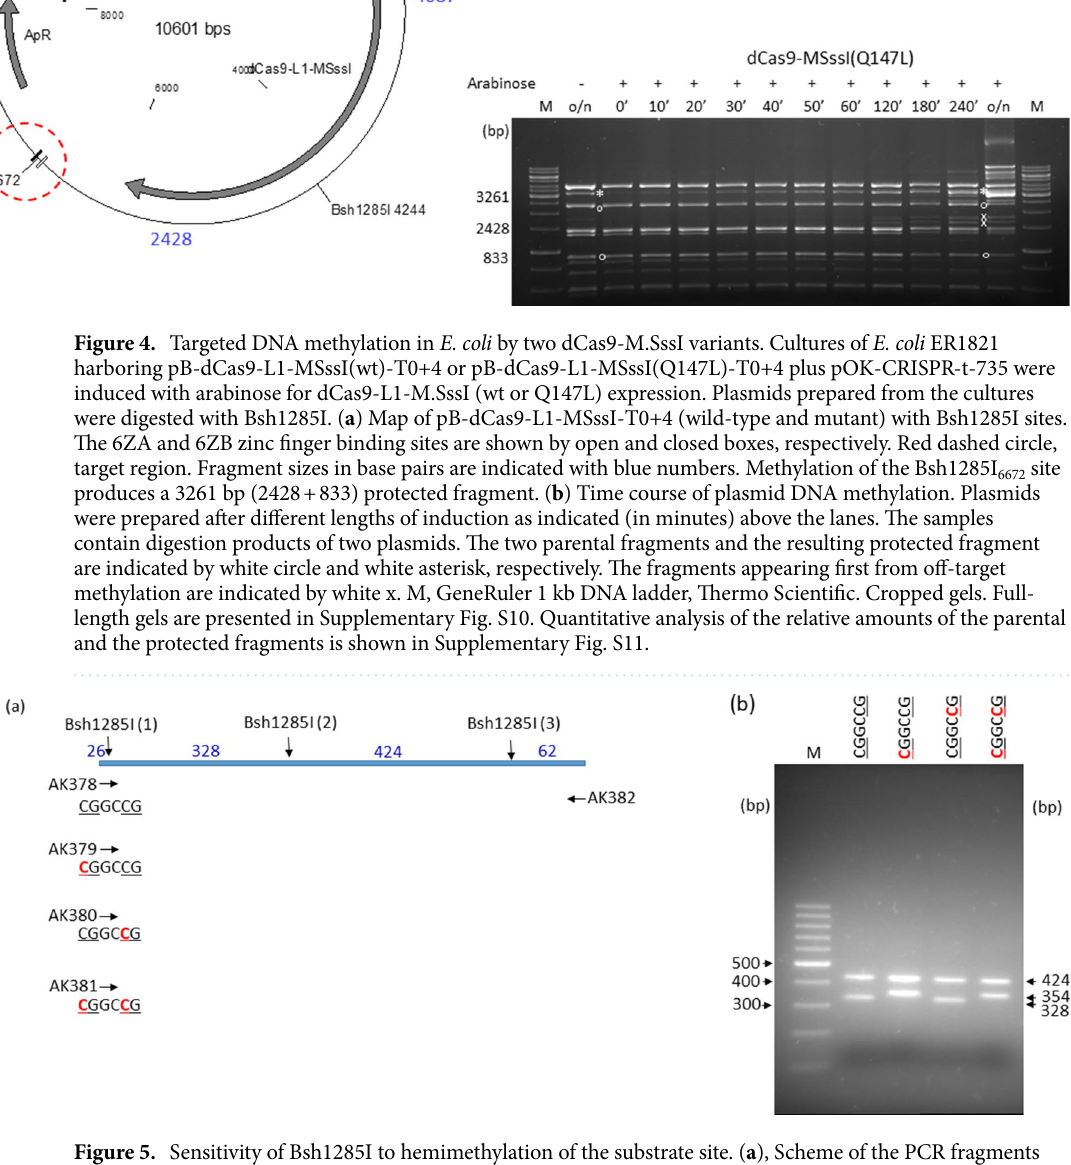
Figure 5. Sensitivity of Bsh1285I to hemimethylation of the substrate site. ( a ), Scheme of the PCR fragments synthesized using the indicated primers. The forward primers differed in the methylation status of the Bsh1285I site (CGG CCG ). Vertical arrows, Bsh1285I cleavage sites; horizontal arrows, PCR primers. Methylation state of the Bsh1285I site is shown below the arrow representing the primer: C5-methylcytosines are shown in red. Numbers above the horizontal bar indicate the length of fragments generated by complete Bsh1285I digestion. ( b ), Agarose gel electrophoresis of the PCR fragments digested with Bsh1285I. Methylation state of Bsh1285I site (1) is shown above the lanes. 1.5% agarose gel; M, GeneRuler 100 bp DNA Ladder (Thermo Scientific). Cropped gel. Full-length gel is presented in Supplementary Fig.